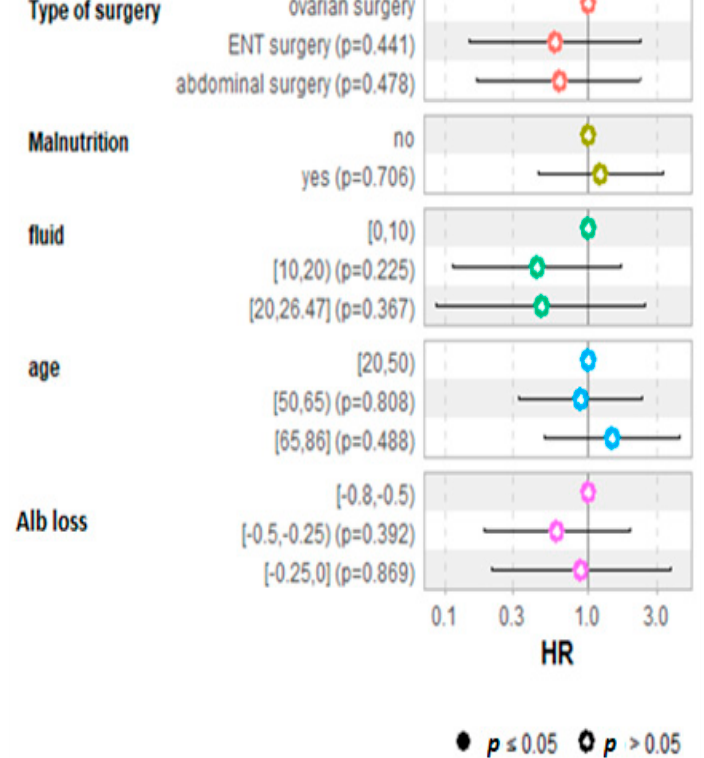
Figure 7. Cox regression hazard ratio for the survival at five years. No variable has any significant influence on